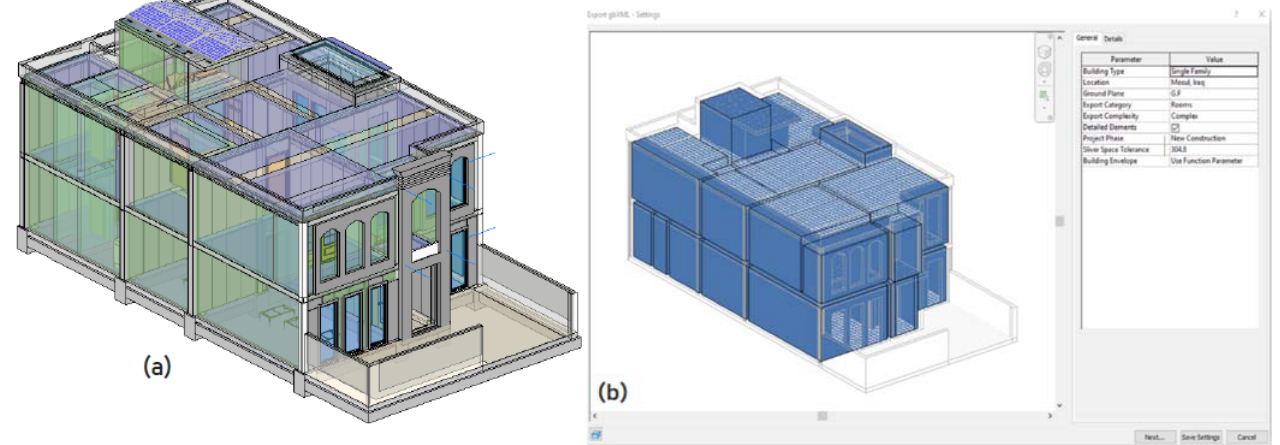
Figure 9. 6D BIM application: ( a ) Energy analytical model, ( b ) Model settings. In Green Building Studio, the weather profile of Mosul city was identified, depending on the geographical location of the city. The database of Green Building Studio conducted the performance analysis for each model, depending on the properties of each model and in accordance with the geographical settings of Mosul city. The 6D BIM